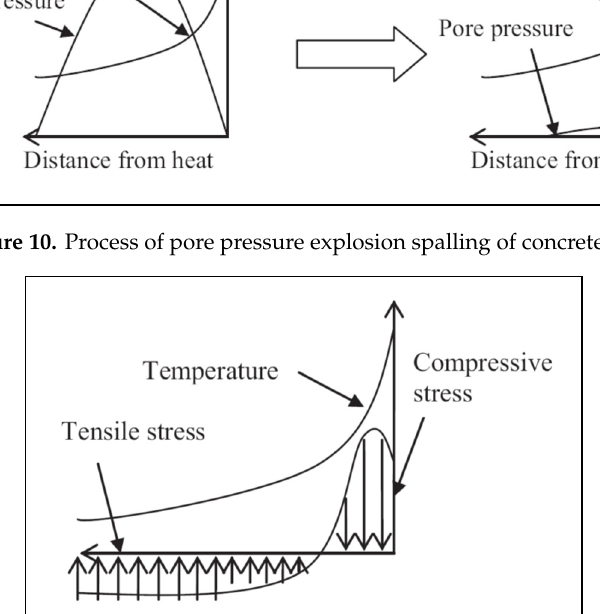
Figure 11. Mechanism of thermal stress explosion spalling of concrete [14].